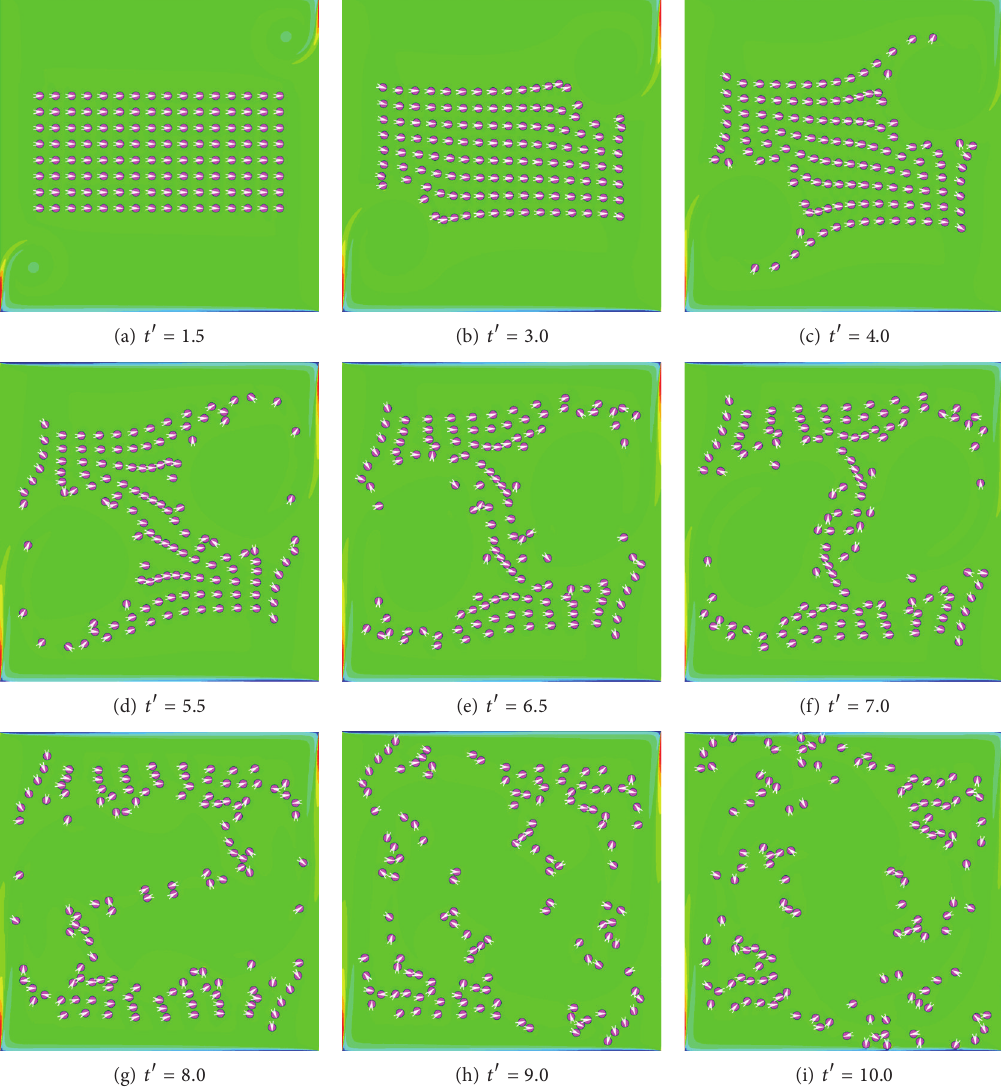
Figure 3: Vorticity contours when 𝑈 0 = 0.1